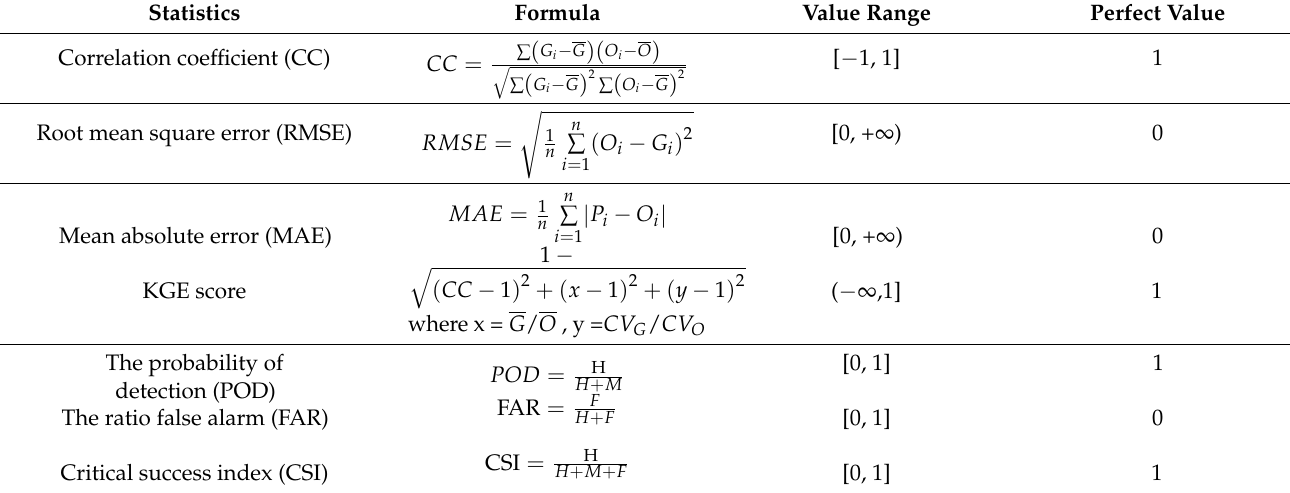
Table 3. Statistical metrics used in the